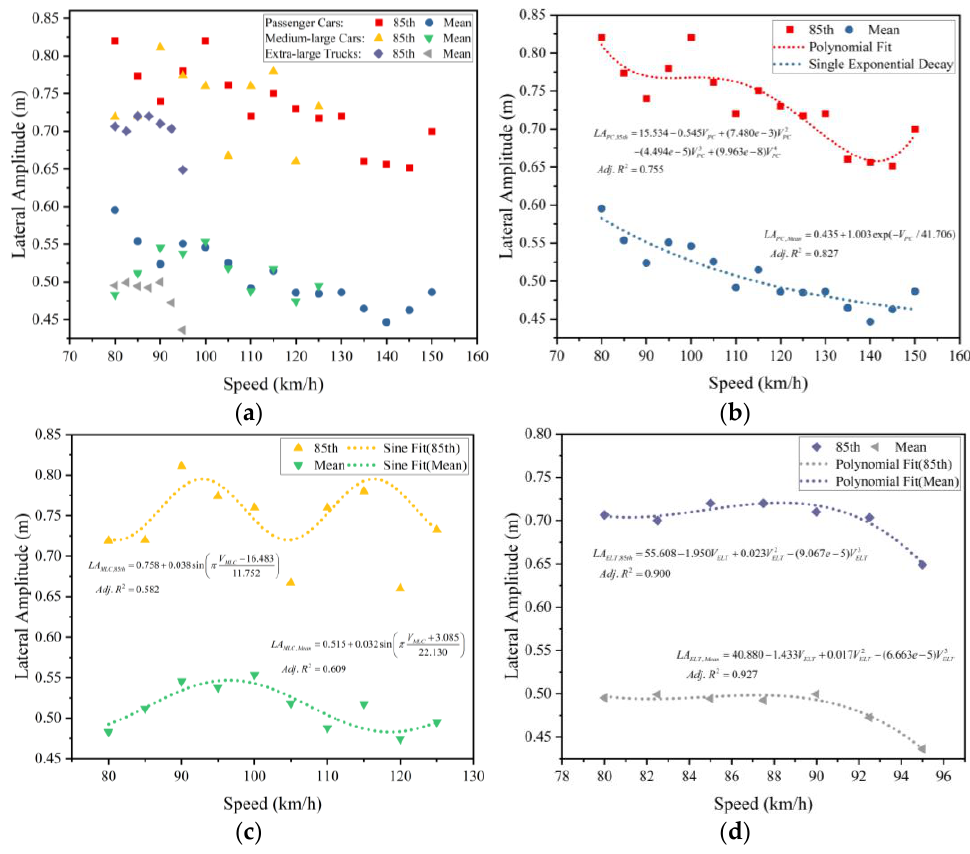
Figure 12. The relationship between lateral amplitude and speed. ( a ) All types of vehicles; ( b ) Pas- senger Cars; ( c ) Medium-large cars; ( d ) Extra-large Trucks. senger Cars; ( c ) Medium-large cars; ( d ) Extra-large Trucks. Table 6. Verification of the lateral amplitude prediction model. Vehicle